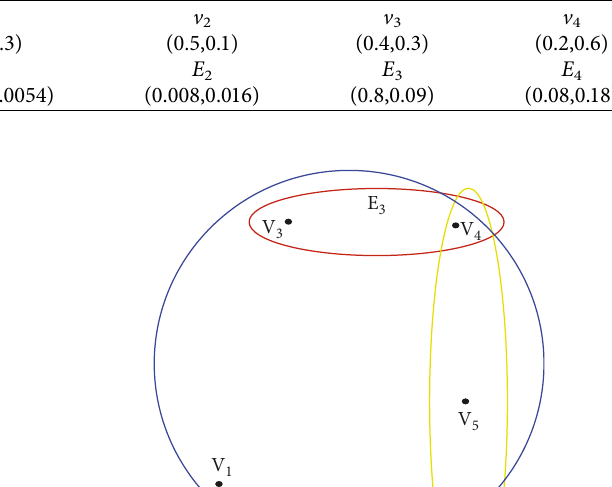
Figure 1: Semi– µ -strong edges of IFHG H. Table 1: Degree of membership and nonmembership values for vertices and edges of Figure 1.